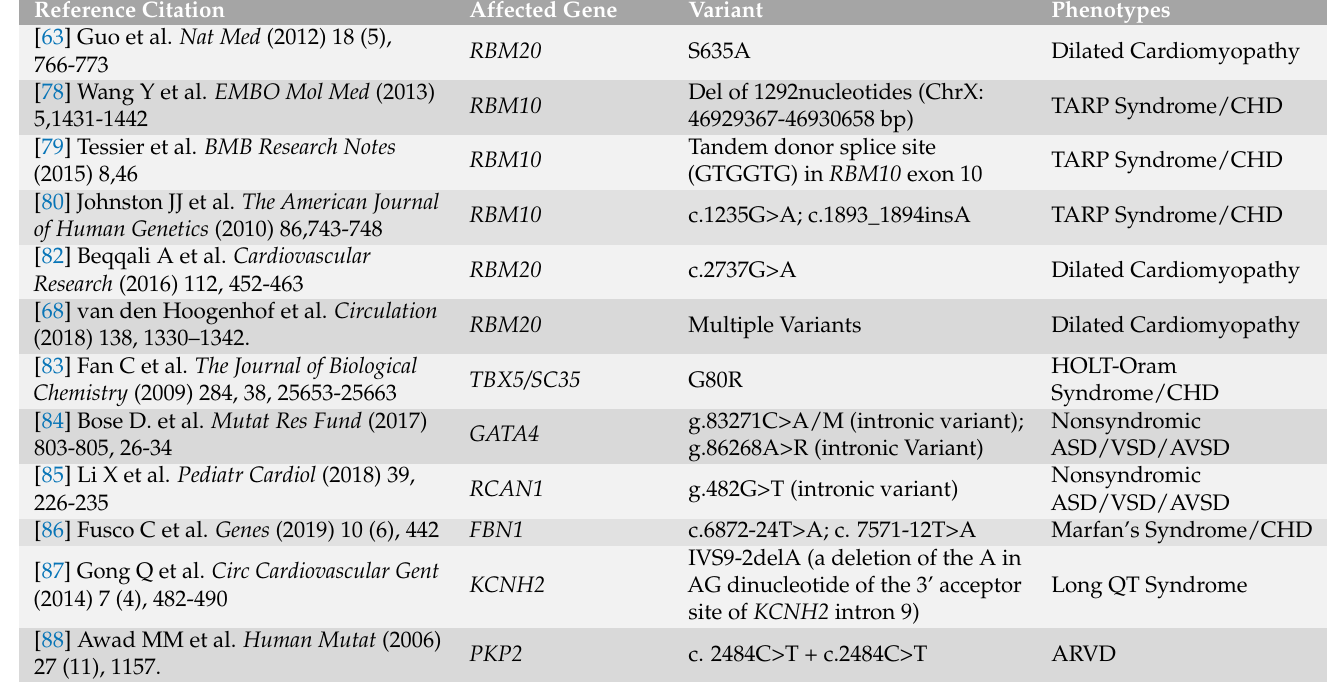
Table 3. Genes affected by pathogenic splicing variants and their contribution to CHDs. Notes: TARP: Talipes equinovarus, Atrial septal defect, Robin sequence, and Persistent left superior vena cava; ARVD: Arrhythmogenic Right Ventricle Dysplasia; AVSD: Atrial Ventricular Septal